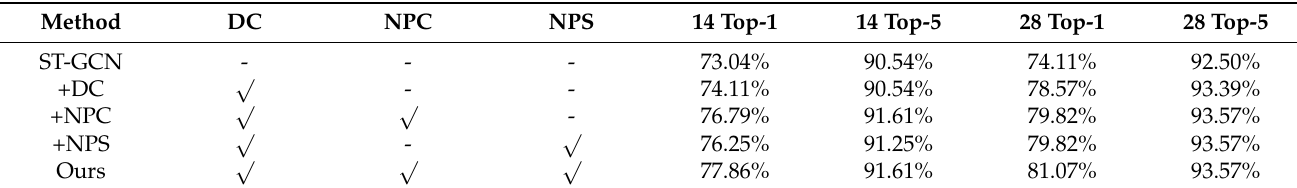
Table 2. Comparison of accuracy of different improvement